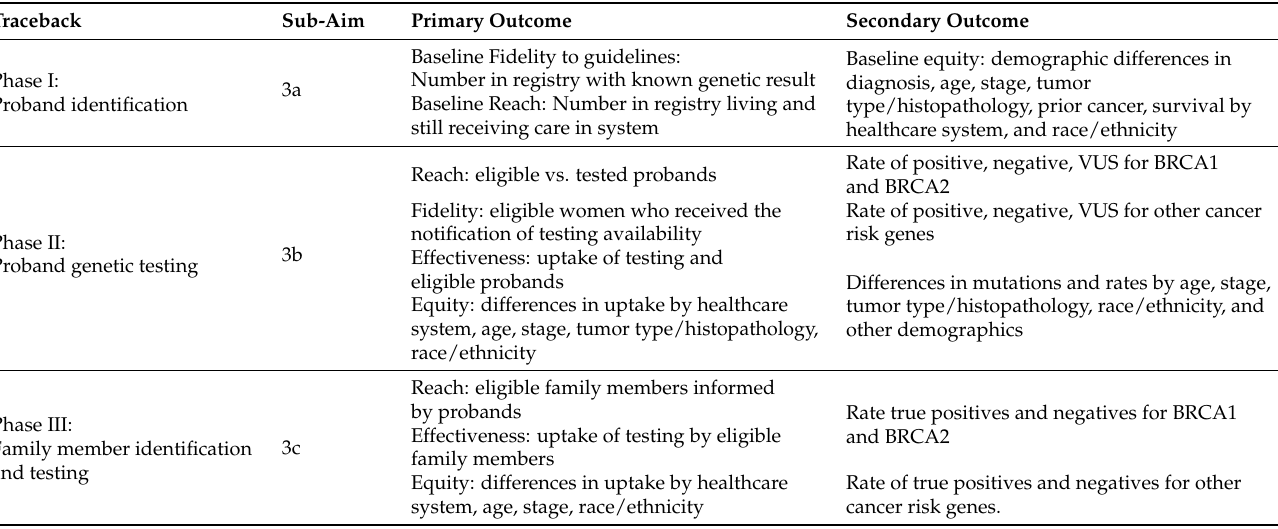
Table 4. Aim 3 quantitative